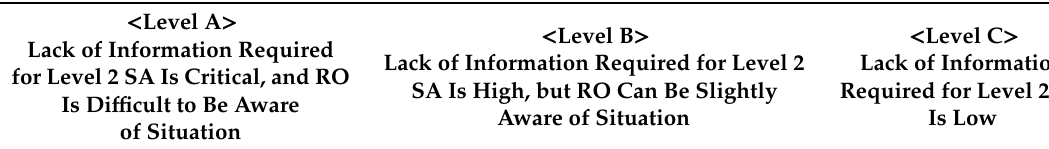
Table 8. Lack of required information for Level 2 SA.